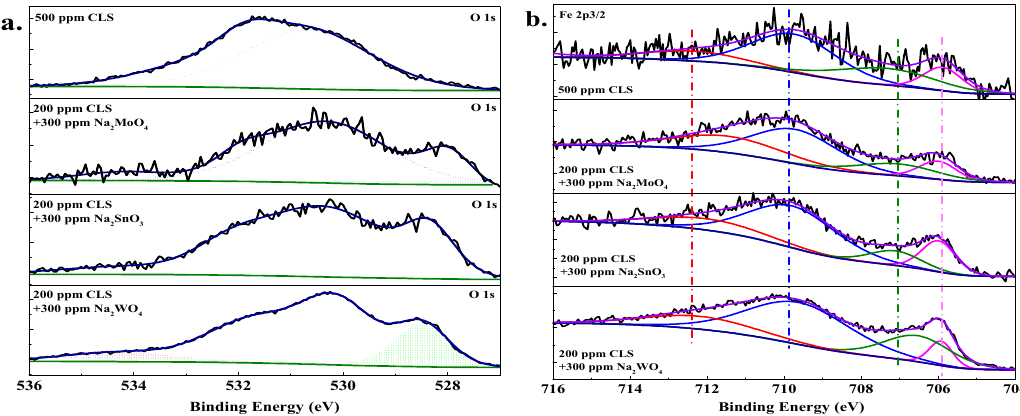
Figure 12. High-resolution X-ray photoelectron spectroscopy (XPS) spectrum of Mo 3d ( a ), Sn 3d ( b ), and W 4f ( c ) for inorganic inhibitor treated steel and CLS + inorganic inhibitor treated steel.